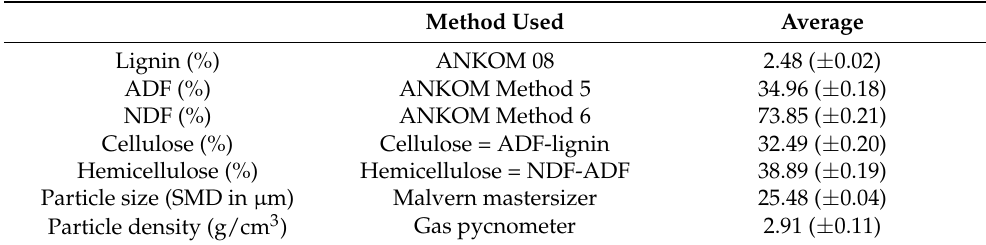
Table 2. Particle filler properties.